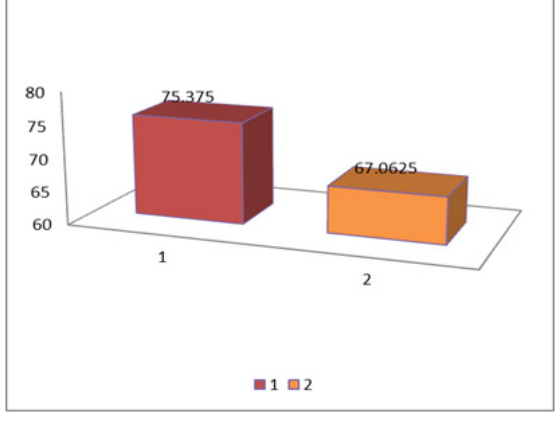
Figure 2. Average value of the two